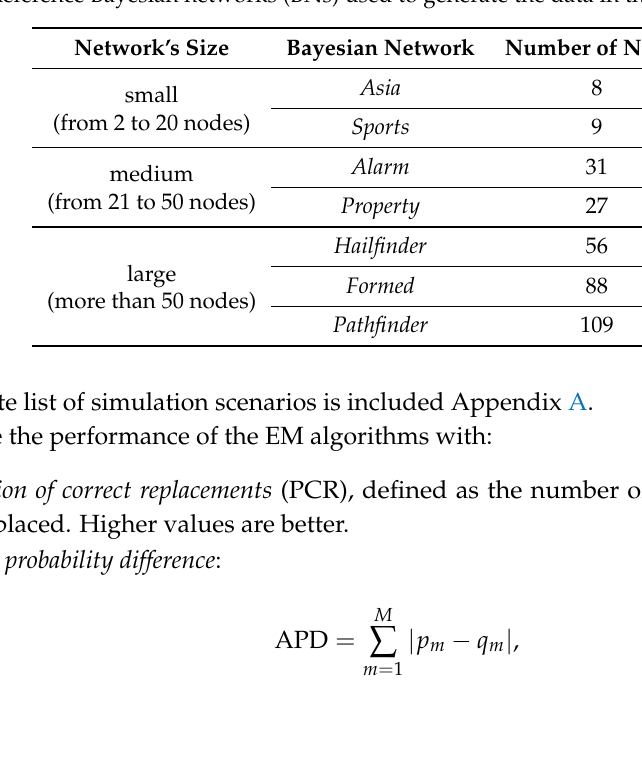
Table 1. Reference Bayesian networks (BNs) used to generate the data in the simulation